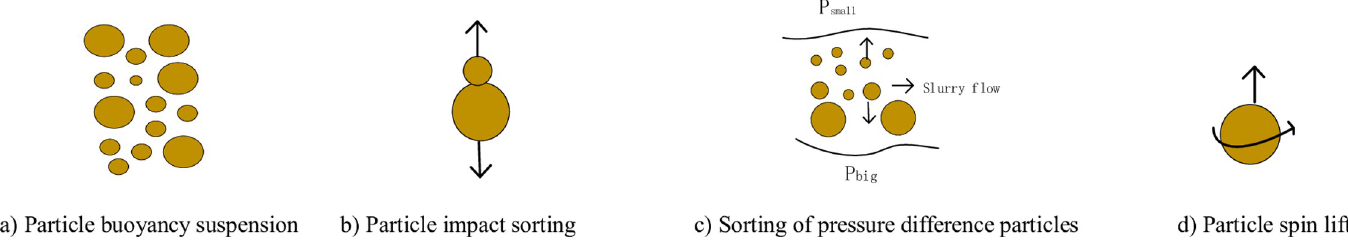
Fig 1. Motion state of flow film particle separation. a) Particle buoyancy suspension, b) Particle impact sorting, c) Sorting of pressure difference particles, d) Particle spin